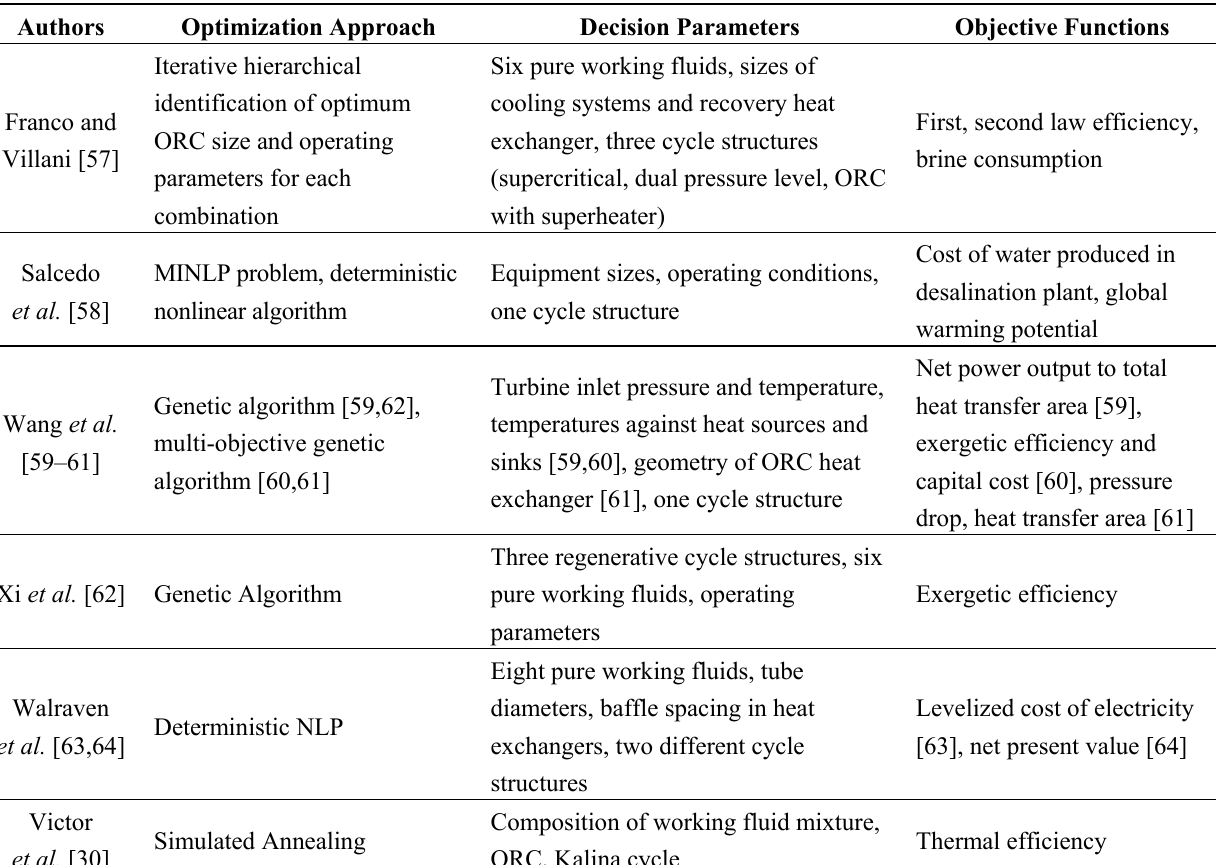
Table 4. Cycle operating/sizing parameters are optimized for different, pre-determined cycle structure and working fluid